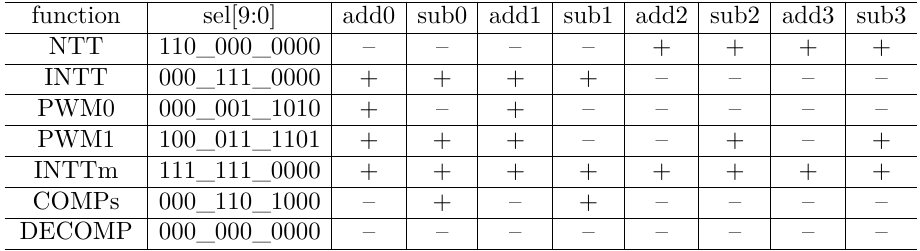
Figure 3: Active operators in two unified butterfly units during NTT (upper left), INTT (upper right), PWM0 (lower left) and PWM1 (lower right) Table 1: Control code of each procedure. Symbol 0 + 0 denotes corresponding operator is in use, while 0 − 0 denotes it is idle at the